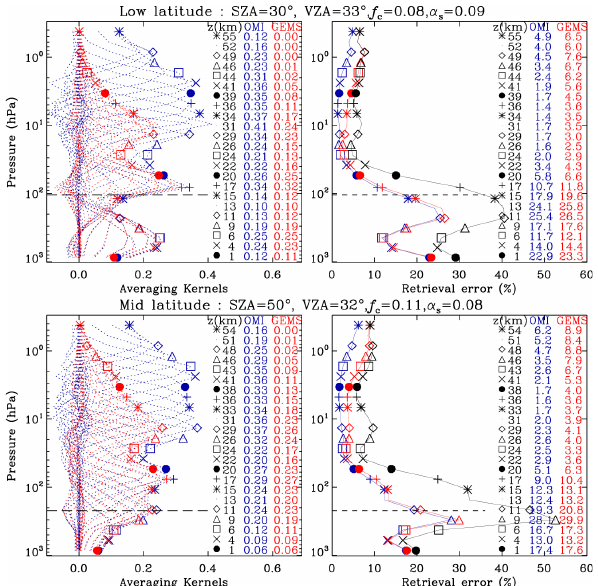
Fig. 2. Comparison of mean averaging kernels and relative retrieval errors (normalized to a priori profiles) at each layer from OMI (blue) and GEMS (red) retrievals, for low latitude (30 ◦ S–30 ◦ N: upper panel) and mid-latitude (30 ◦ S/N–60 ◦ S/N: lower panel). The asso- ciated a priori error is also plotted with black line in right figures. In this analysis, we only consider pixels with cloud fraction of less than 0.3 and surface albedo less than 20%. The caption includes the average conditions for low/mid-latitude pixels: solar zenith an- gle (SZA), viewing zenith angle (VZA), cloud fraction ( f c ) , and surface albedo ( α s ) . The dashed line denotes the mean tropopause height. The first column of each legend gives the center altitudes of the 24 layers. The other two columns in the left figures give DFS; in the right figures they give relative retrieval errors (%).